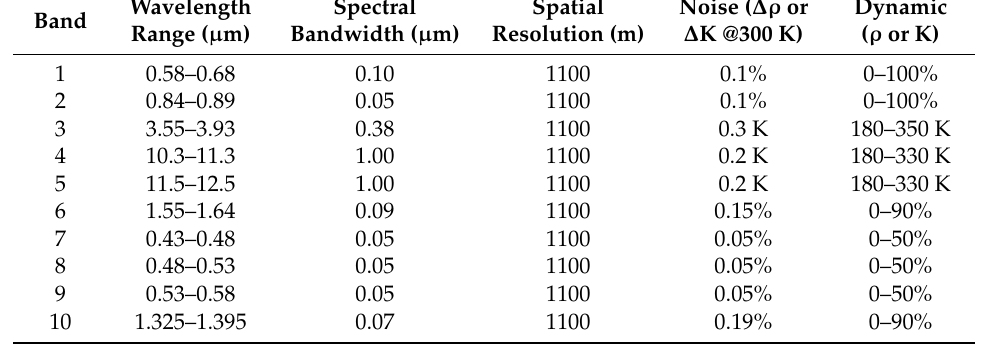
Table 1. FY-3 (A, B, C)/VIRR spectral band specifications.